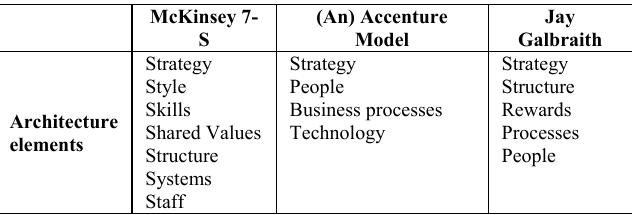
Table 2: Consultancy examples of organisational